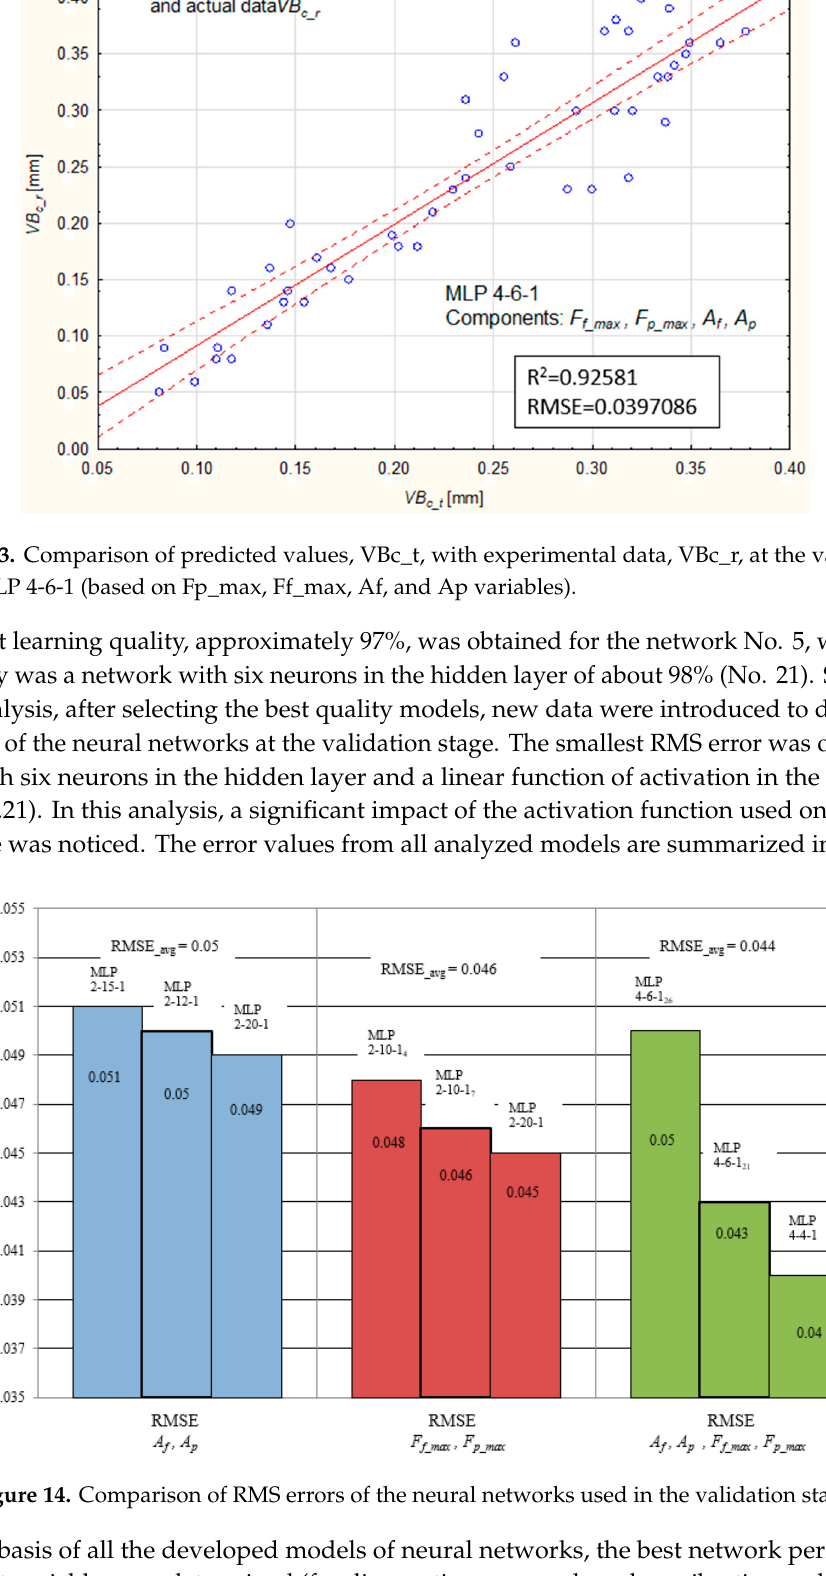
Table 7. The RMSE values for three MLP neural network (based on four variables).